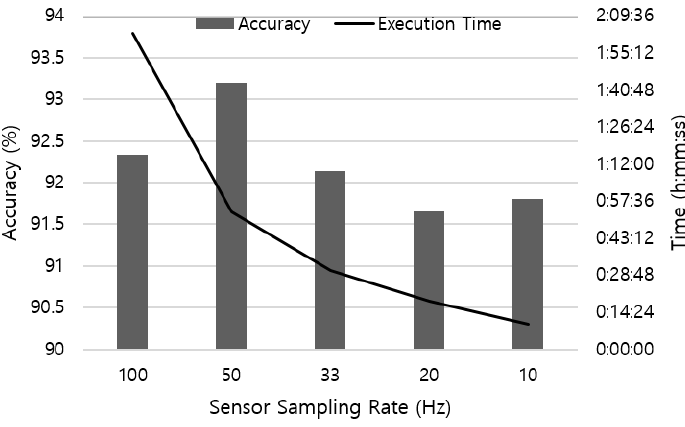
Figure 6. Recognition accuracy and execution time according to different sampling rate of the